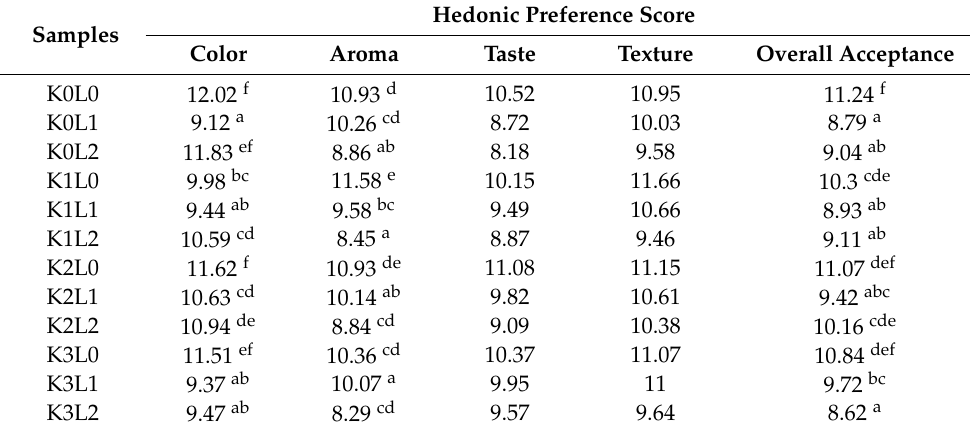
Table 5. Sensory properties of the stink lily noodles.